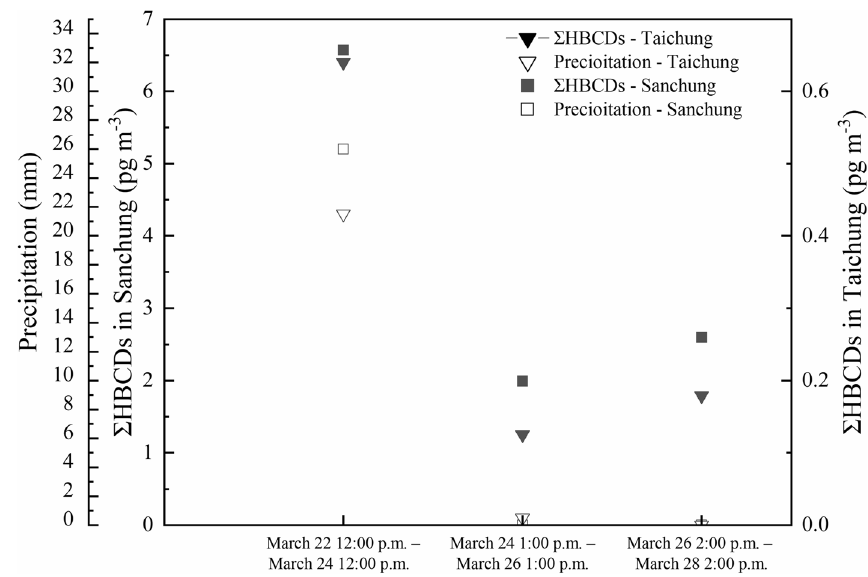
Fig. 5 Concentrations of HBCDs and the precipitation in both sampling